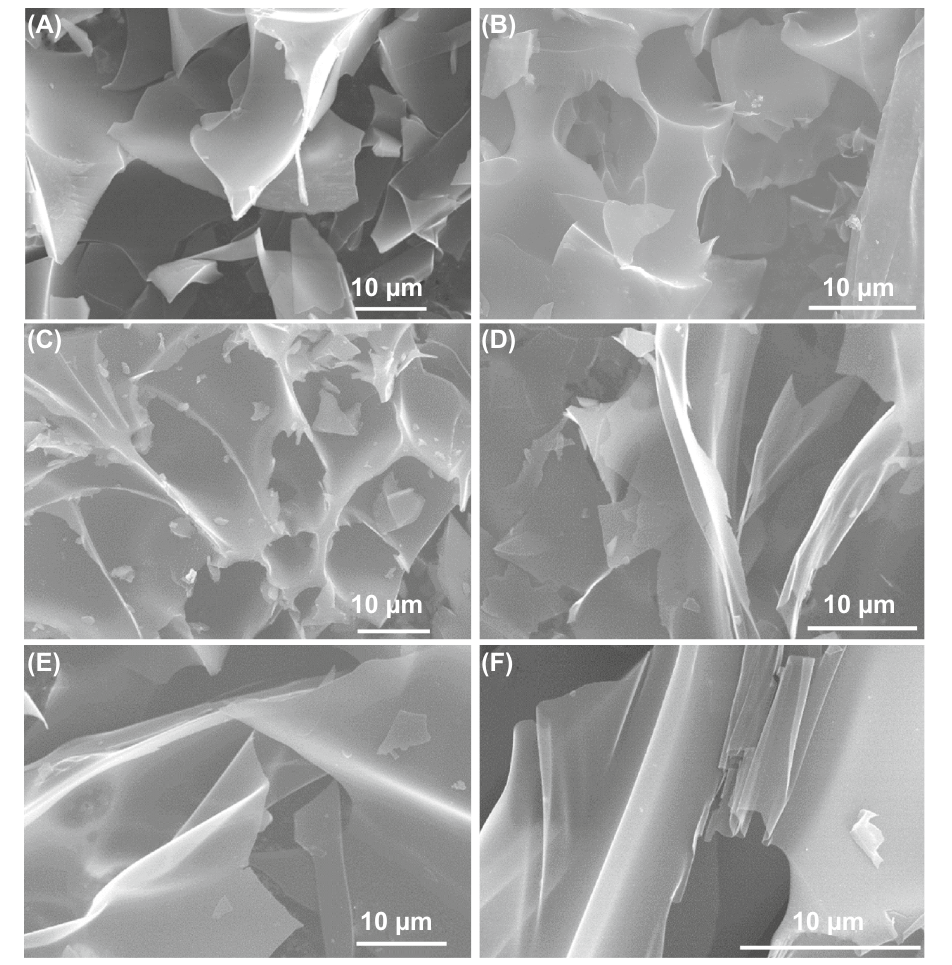
Fig. 4 SEM images of A HPNCF-2.0-700, B HPNCF-2.0-800, C HPNCF-0.75-900, D HPNCF-1.0-900, E HPNCF-1.5-900, and F HPNCF-